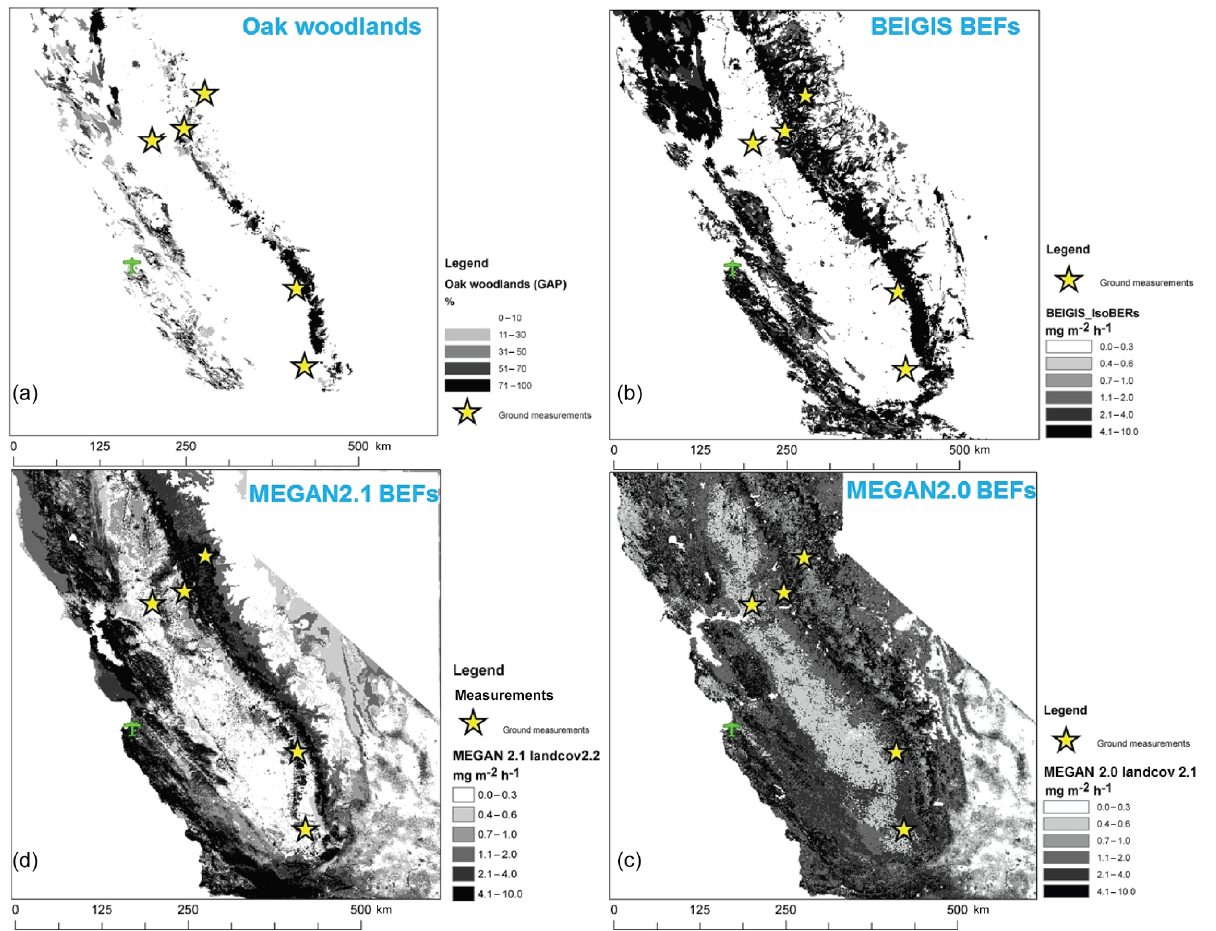
Figure 2. Land covers used by the models. (a) GAP’s oak woodlands, (b) BEIGIS emission factors as dtiso+eiso (the sum of emission factors for deciduous and evergreen trees) derived from the GAP database, (c) MEGAN v.2.04 isoprene emission factors derived from land cover v.2.1, and (d) MEGAN v.2.1 isoprene emission factors obtained from the most recent land cover